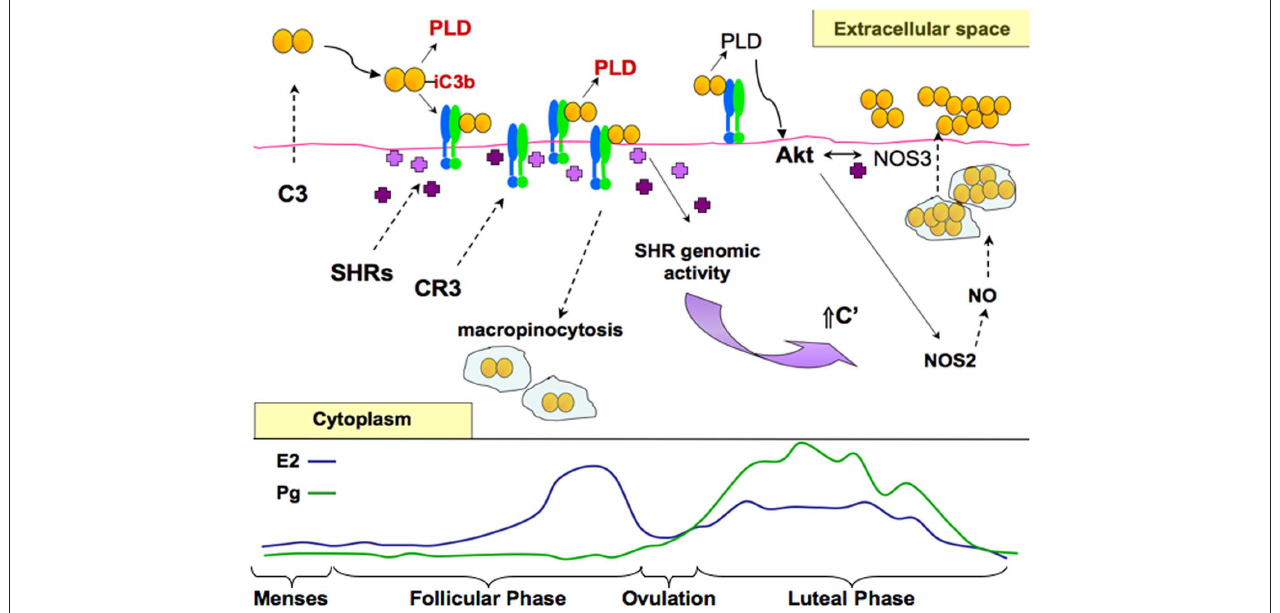
with pex cells. Engagement of CR3 triggers the recruitment of SHRs to the cytoplasmic domain of CR3 where they likely participate in the cervical cell signaling pathways triggered with gonococcal infection. The direct interaction of (Ng)PLD with (host) Akt, triggers ruffle formation and the internalization of gonococci within macropinosomes. Levels of CR3 on the surface of both uninfected and infected pex cells decrease with increasing E2. This might indicate that the internalization of gonococci is augmented by E2 in the mid-follicular phase. Gonococcus-containing vacuoles coalesce near the apical surface within pex cells, and CR3 is disengaged. Protein secretion by intracellular gonococci residing within the macropinosome under conditions of low Pg is likely down-regulated as a consequence of rapid C3 depletion. However, as progesterone levels begin to rise, C3 levels also would again increase because of transcription factor activity exerted upon the C3 gene by SHRs. It is then expected that Akt activity would be increasingly maintained as more PLD is released by gonococci in the presence of increased C3(b). The ability of Pg to promote the intracellular survival of gonococci occurs in part by augmenting Akt activity, which triggers nitric oxide (NO) production. NO supports (micro)aerobic respiration by intracellular (and extracellular) gonococci. Late in the luteal phase, Akt activity decreases with progressively decreasing Pg. Decreasing Akt, which also plays a role in cellular trafficking, in conjunction with other host and bacterial constituents, may modulate the release of C3 and gonococci from pex cells to the extracellular cell surface where ever increasing numbers of bacteria colonize the cell surface, eventually leading to the formation of